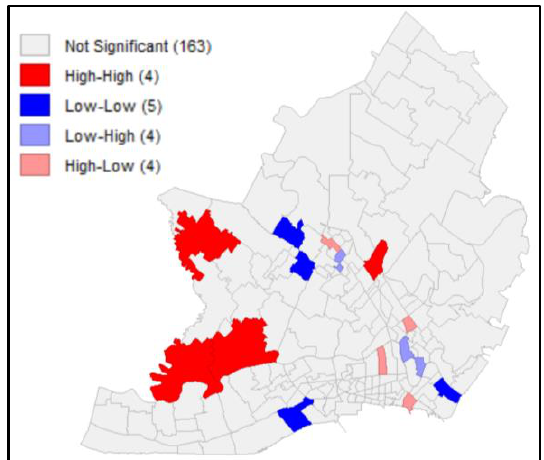
Figure 2. Local migration for each brgy no clustering, Moran’s